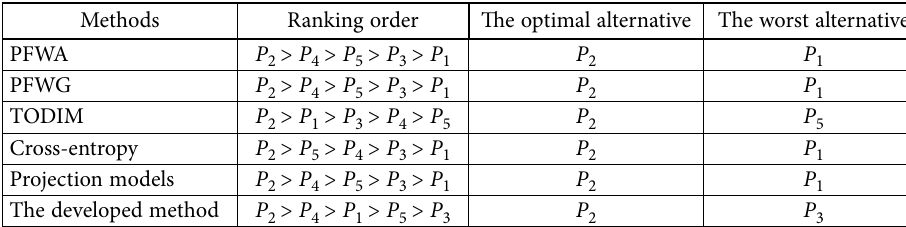
Table 7. Evaluation results of dissimilar